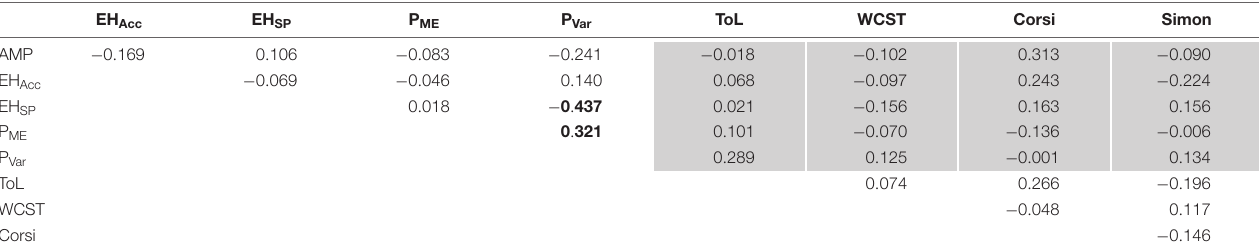
Values in bold type represent significant correlations, p < 0.05. Gray boxes are the relationships between sensorimotor and EFs. AMP, Anticipatory motor planning; EH SP , Eye-hand coordination spatial precision; EH Acc , Eye-hand coordination accuracy; P ME , Proprioceptive matching error; P Var , Proprioceptive variability; WCST, Cognitive flexibility; Corsi, Working memory; ToL, Planning and problem-solving; Simon, Inhibitory control. TABLE 3 | Partial correlations controlled for age between sensorimotor skill components and measures of executive functioning in adolescents. EH Acc EH SP